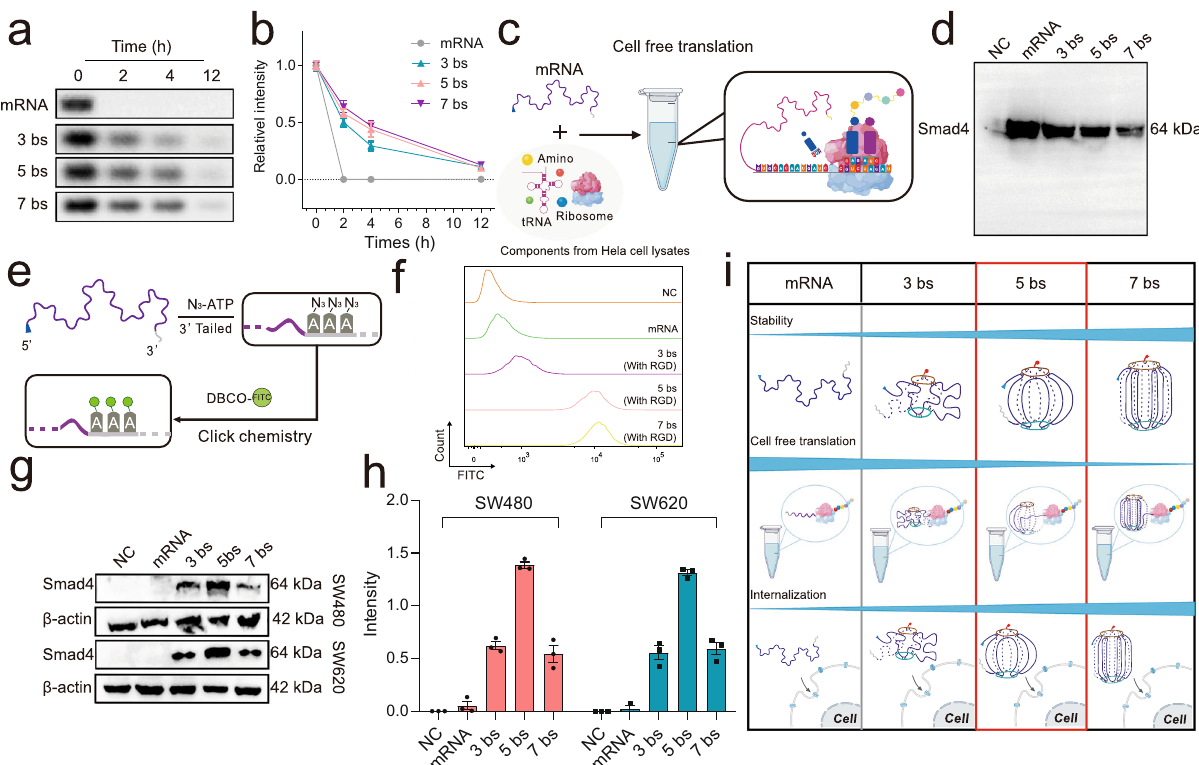
Fig. 3 | Screening of nano-lanterns with different binding sites. a Agarose gel electrophoresis of stability of naked mRNA and different forms of mRNA nano- lantern treated with 10% fetal bovine serum (FBS) for 2, 4, and 12h, respectively. b Intensity statistical of panel ( a ), n =3 independent experiments, data are pre- sentedasthemean±SEM. c Schematicillustrationofcell-freetranslationofmRNA. ( d ) Western blot analysis of protein expression level of individual mRNA and dif- ferent forms of mRNA nano-lantern (3, 5, and 7bs) in the cell-free translation sys- tem, n =3independentexperiments. e Schematicillustrationoftheconstructionof FITC labeled mRNA. ( f ) Intake pro fi les of FITC labeled nano-lantern (with 3, 5, and